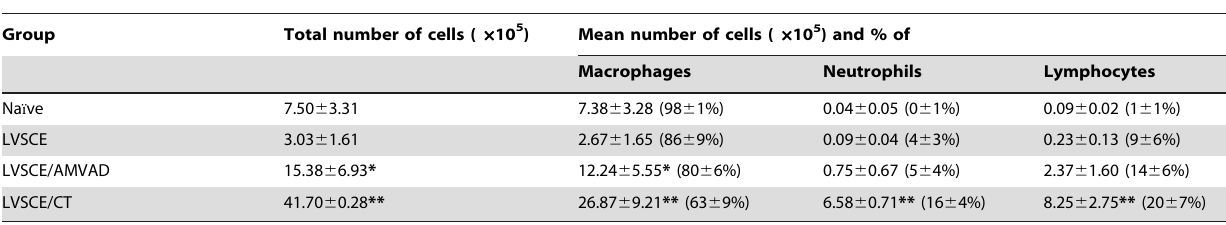
Table 1. Cell populations in the bronchoalveolar lavage fluids of mice at 28 d (7 d post third immunization at 21 d).